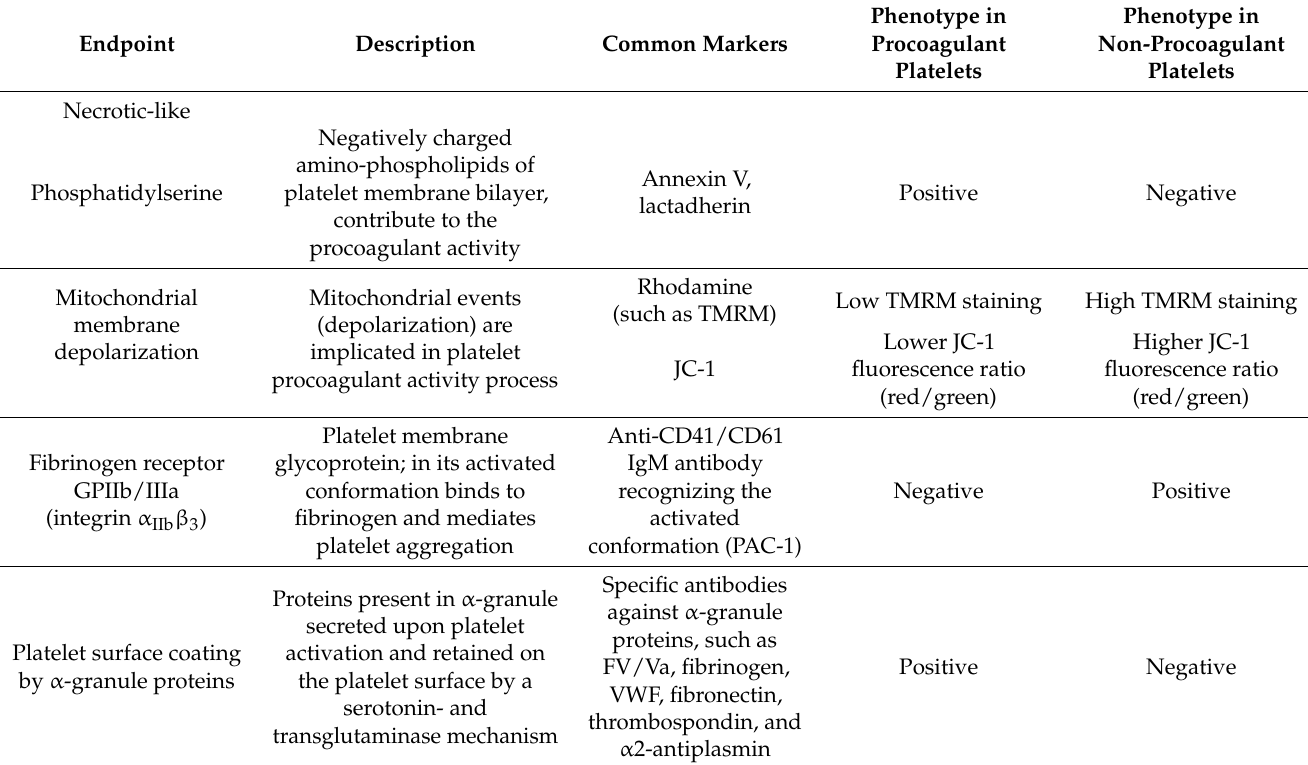
Table 1. Activation endpoints of procoagulant platelets and common flow cytometry markers to detect and discriminate them. Endpoint Description Common Markers